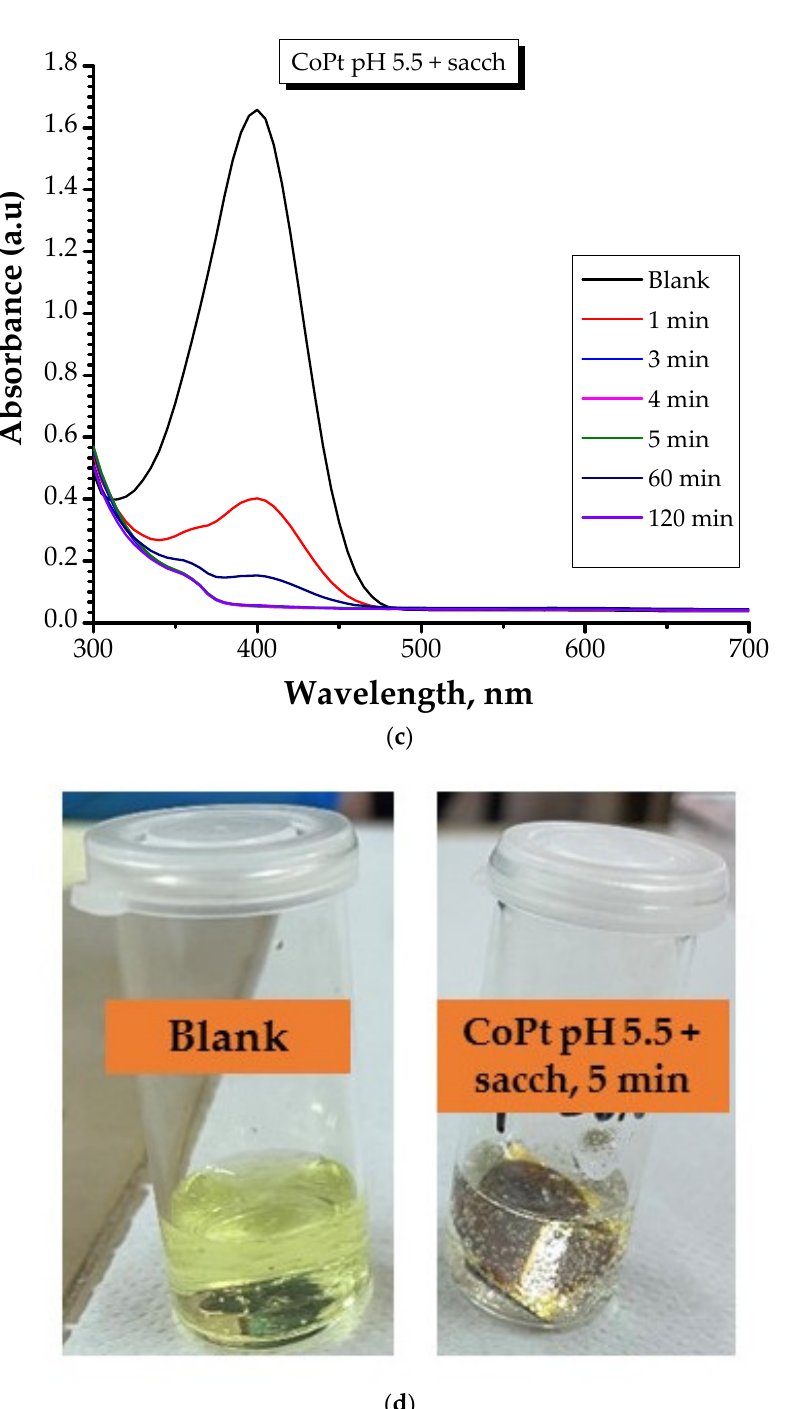
Figure 8. Absorption spectra of the conversion of 4-Nitrophanolate anion over time by: ( a ) CoPt pH 2.5 + sacch (sample S2) and ( c ) CoPt pH 5.5 + sacch samples measured for 120 min contact time; (sample S4); ( b ) Optical view of the color of the solution mixture for CoPt pH 2.5 + sacch (sample S2); ( d ) Optical view of the color of the solution mixture for CoPt pH 5.5 + sacch (sample 4). After reviewing the data, it can be highlighted that: (i) in the case of CoPt prepared at pH = 2.5 in the presence of saccharin (sample S2), with increasing contact time, the color of the mixture progressively diminished; (ii) in the case of CoPt prepared at pH = 5.5 in the presence of saccharin (sample S4), the absorption peak at 400 nm \ disappeared